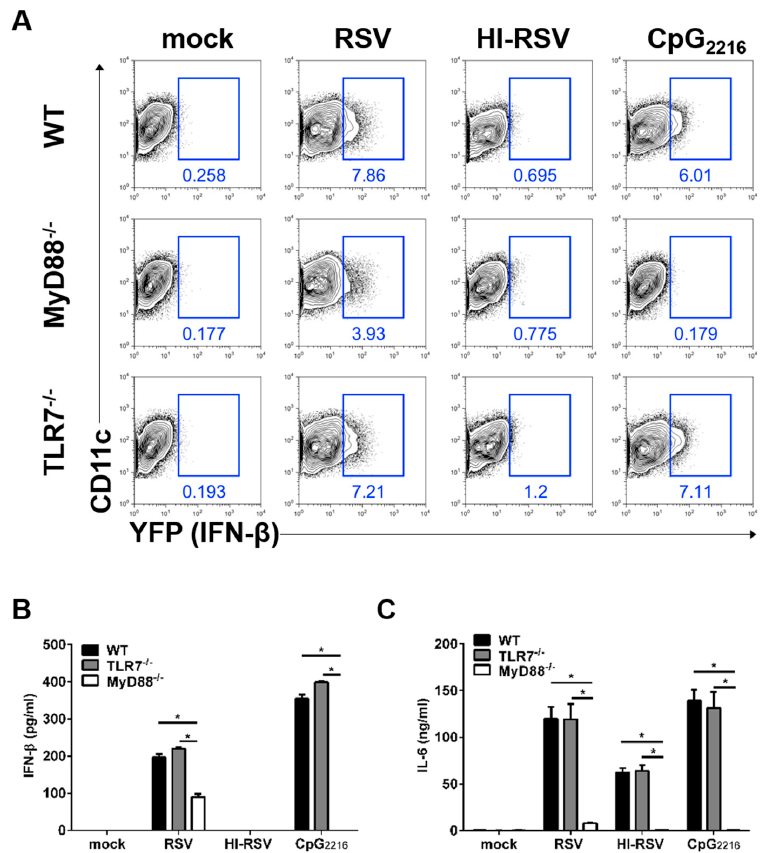
Figure 2. The MyD88-mediated pathways, but not TLR7-mediated pathway, are required for